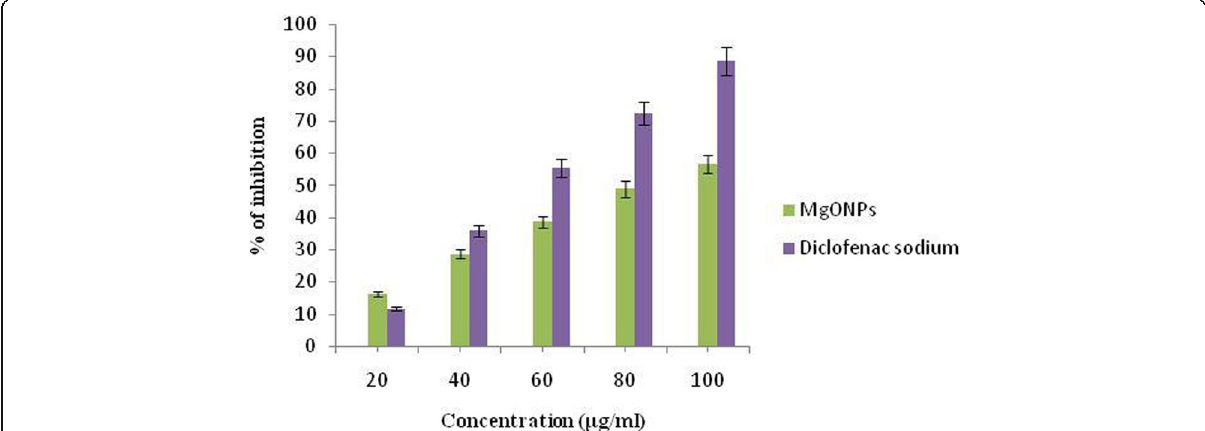
Fig. 10 Representing the albumin inhibitory activity calculated at different concentrations of biosynthesized MgO-NPs and Diclofenac sodium